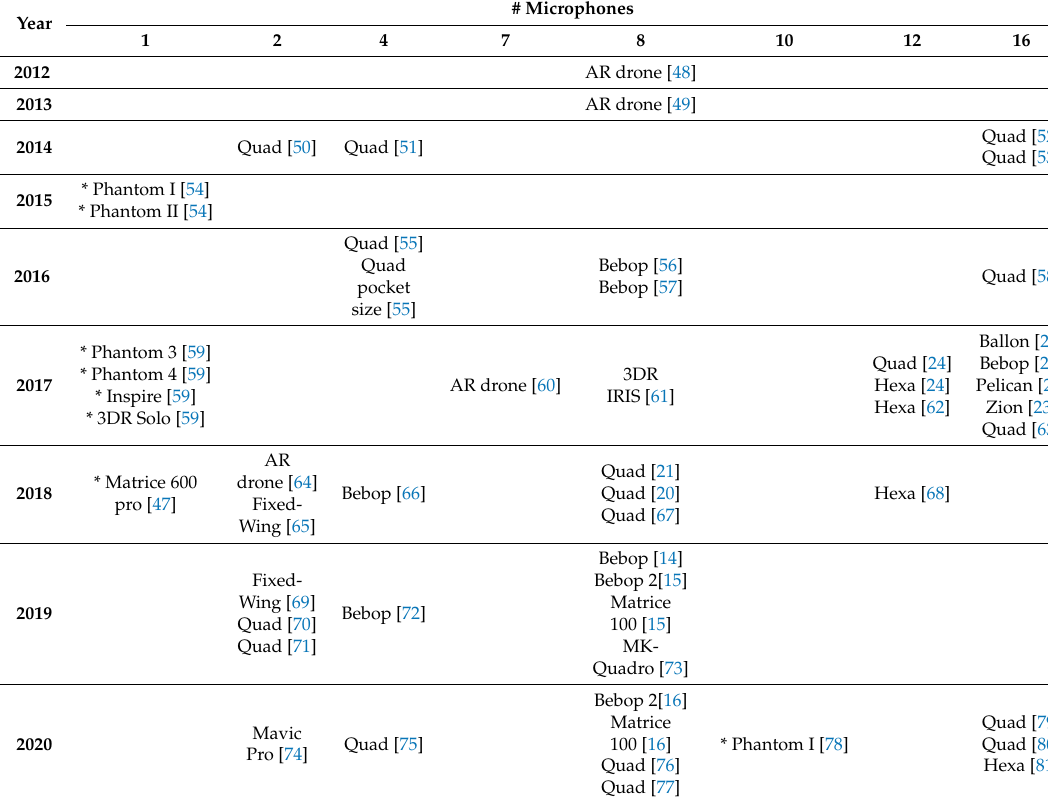
Table 2. UAV types or models (if commercial) grouped by year and number of microphones. Works falling into the air-to-land category are marked with